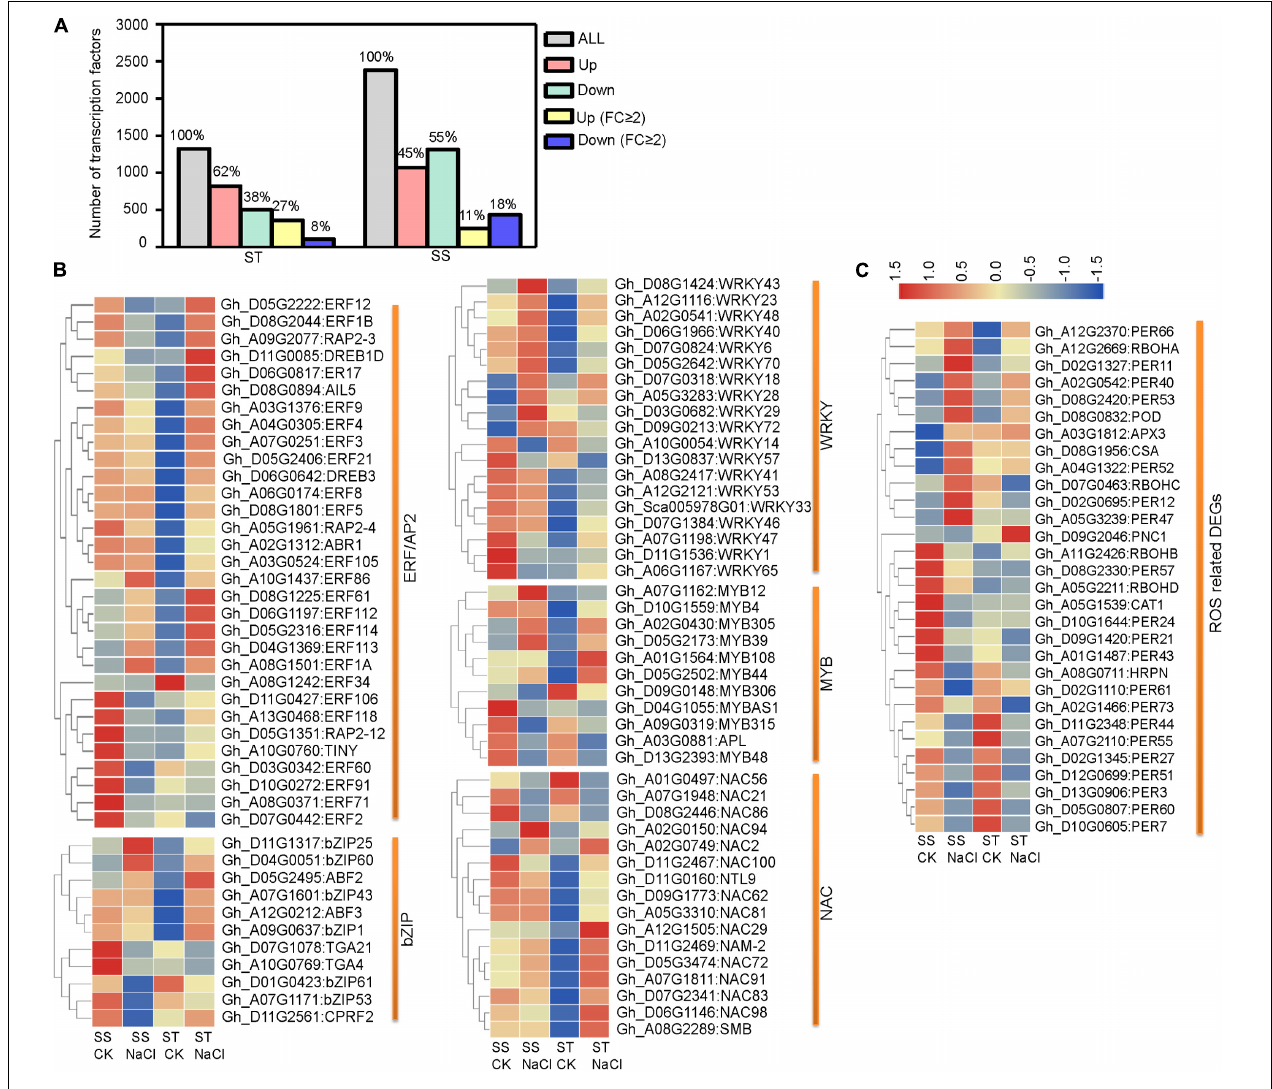
FIGURE 5 | Differentially expressed transcription factor- (TF) and reactive oxygen species- (ROS) related genes in ST and SS were analyzed. (A) Histograms show all TF genes and DEGs with a 2-fold or greater change in expression. (B) Heatmaps show FPKM values of five TF DEGs and (C) ROS-related DEGs in ST and SS. The FPKM values are represented with a color gradient from low (blue) to high